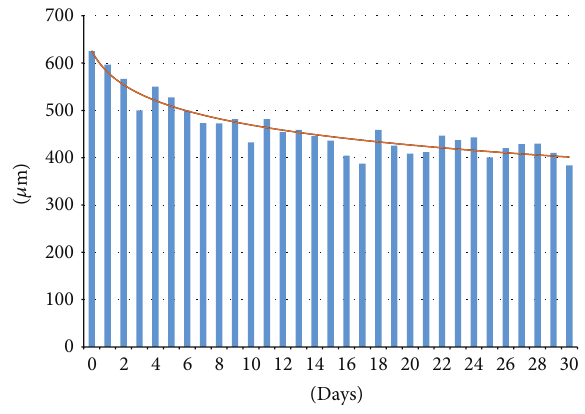
Figure 4: Mean CRT measurements (microns) during the 30-day